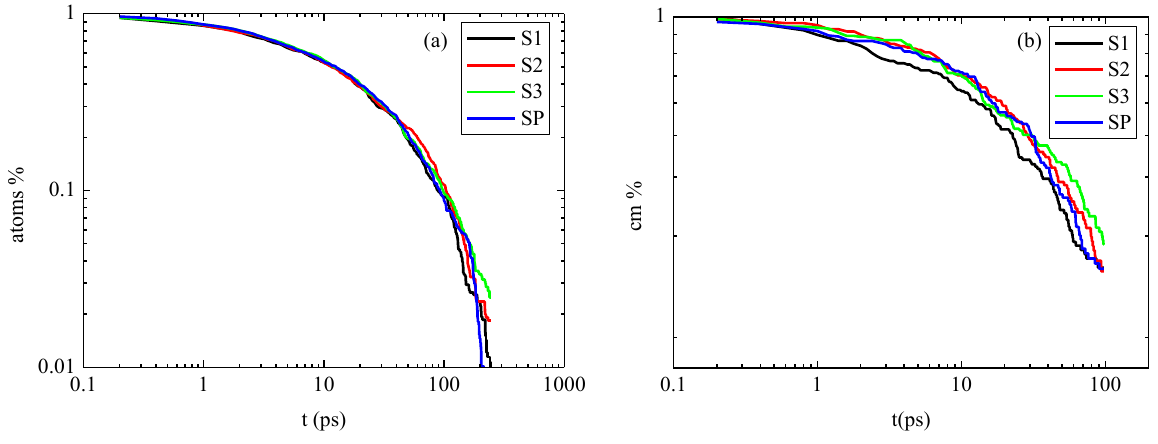
Figure 11. Evolution of the percentage of ( a ) polymer atoms and ( b ) chain center-of-masses that are within the adsorption regime, as a function of time for all